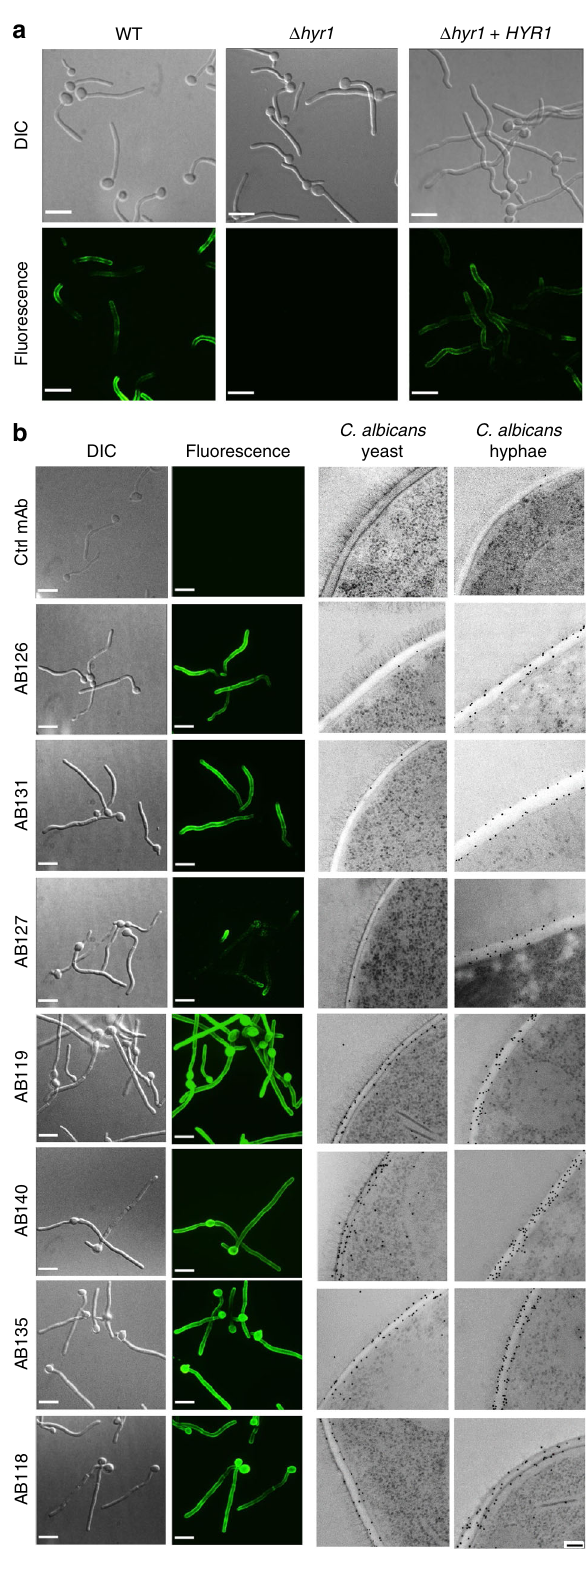
major clonal cluster was chosen as a representative for further screening against polysaccharides and glycoproteins that contain oligosaccharide sequences found in fungal cell walls (Supple- mentary Table 7) and against mammalian-type N -glycans (Sup- plementary Table 8) in an immobilised glycan microarray format 53 . Glycan microarray studies were conducted in